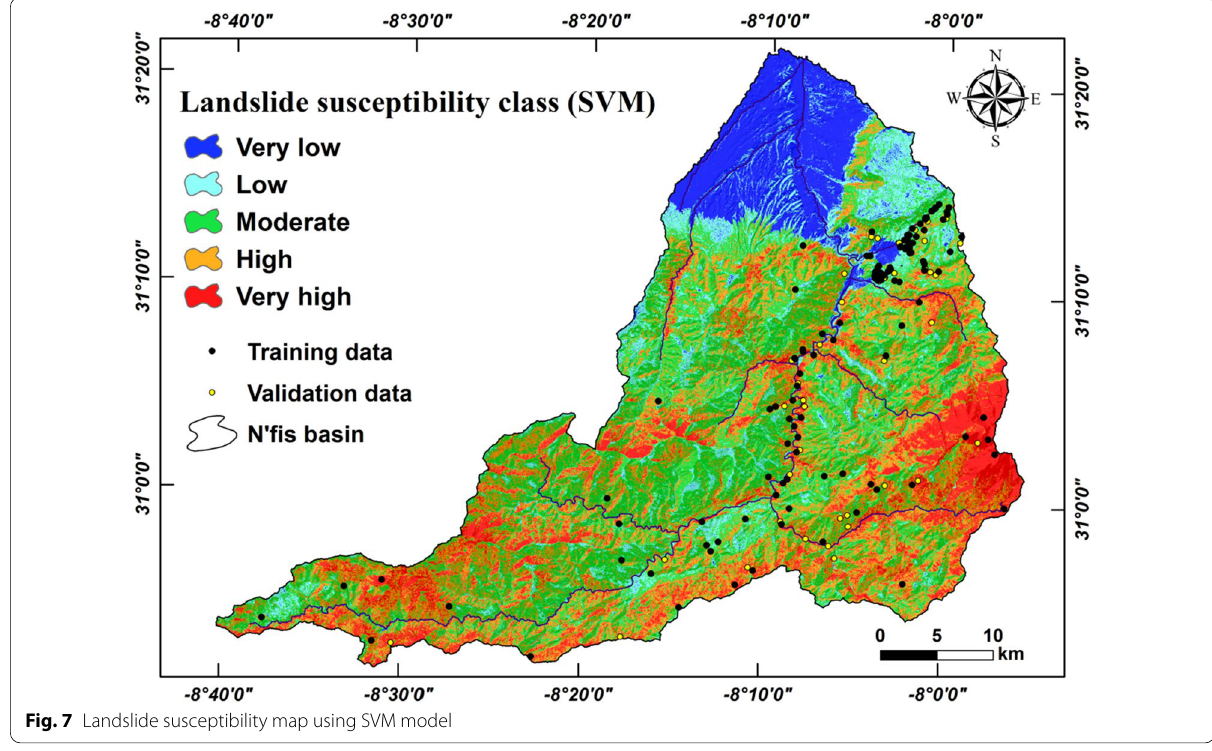
Fig. 7 Landslide susceptibility map using SVM model